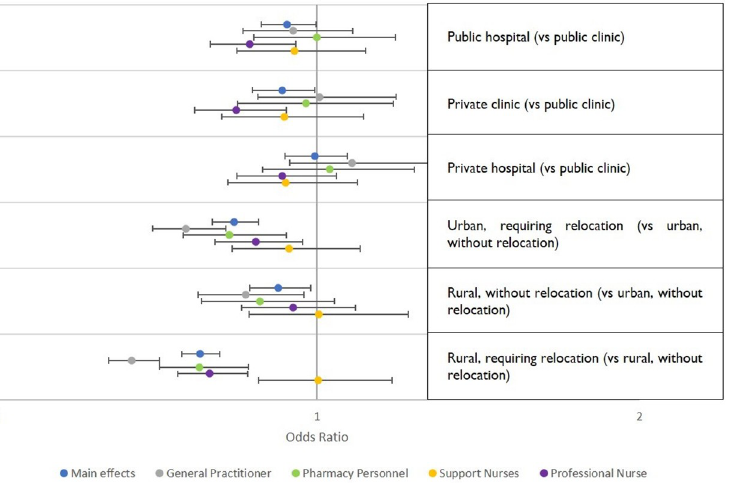
Fig 2. Preferences regarding sector, facility type and location by healthcare worker cadre. This figure shows results of models stratified by cadre, including odds ratios and 95% confidence intervals, for attributes related to workplace type, sector, and